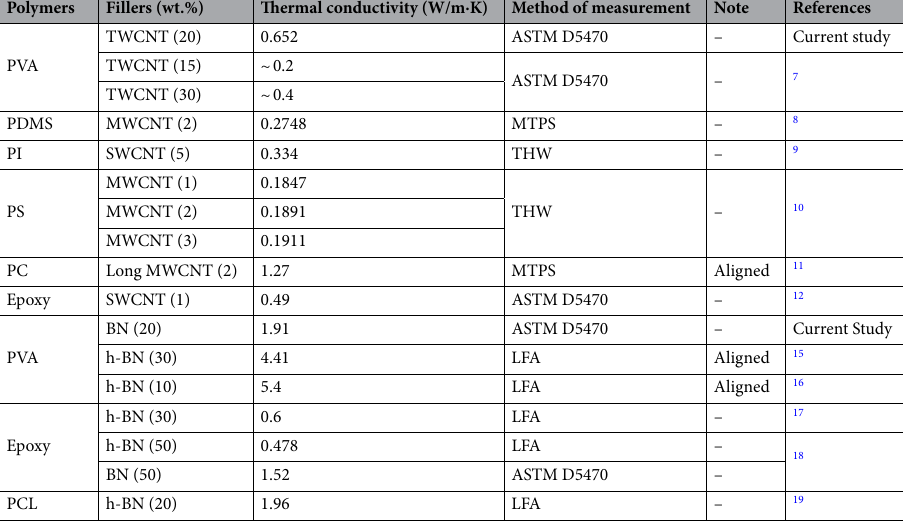
Polymers Fillers (wt.%) Thermal conductivity (W/m∙K) Method of measurement